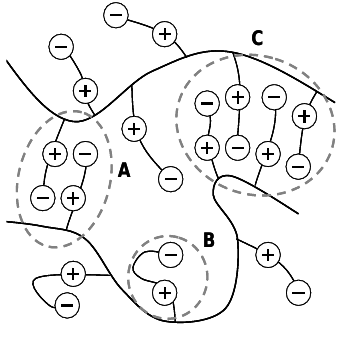
Figure 3. Short zwitterionic cluster ( A ), intragroup ion pair ( B ), long zwitterionic cluster ( C ), nucleated from a short cluster with entropy driven propagation outwards. Figure adopted from